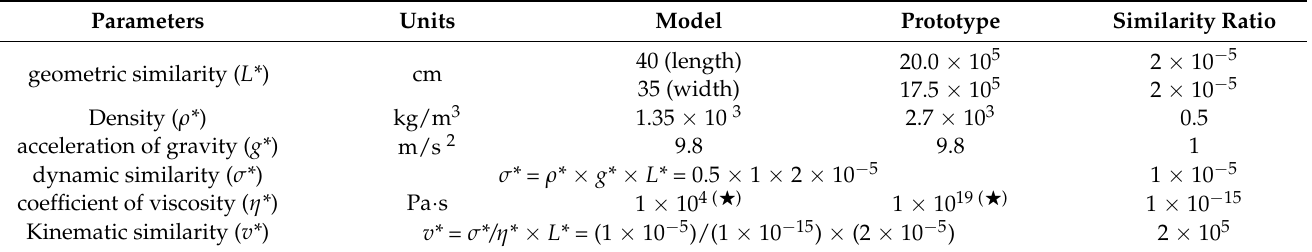
Table 1. The experimental parameters between the model and prototype.